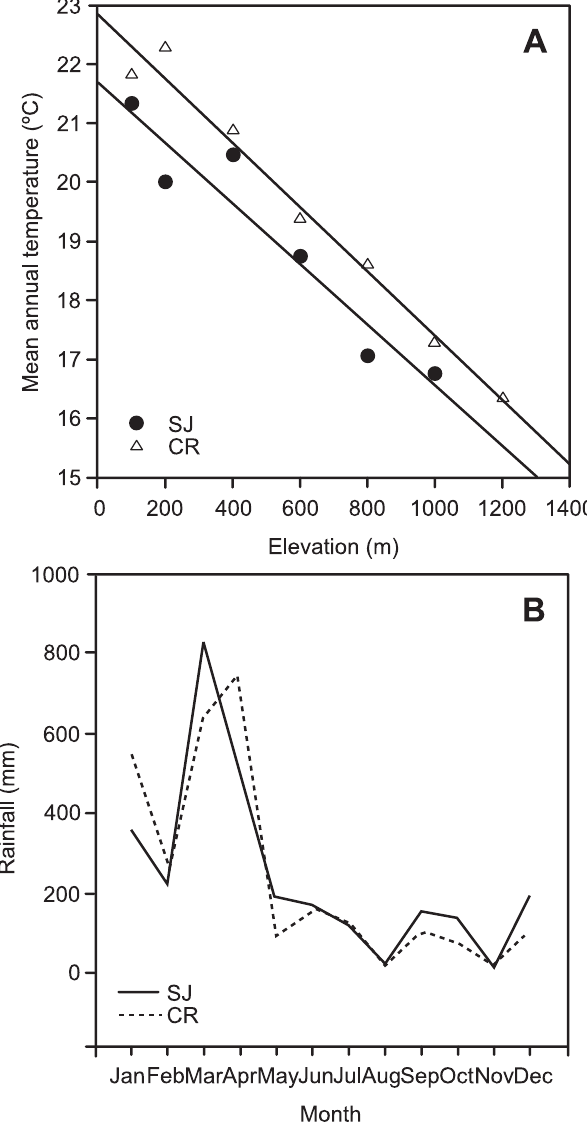
Figure 1. Variation of temperature and rainfall at the AWT. A) Predicted variation of Mean annual temperature as a function of elevation. Temperature decreased at an approximately rate of 1 u C per 200 m altitude and there was approximately 1 u C difference between the two localities sampled at the same elevation and B) Monthly variation of rainfall at the two localities within the region indicated that the dry season began on May and was extended and acute through November or December when the rainy season began. The highest values of rainfall were between February and May. Localities: South Johnston (SJ) and Carbine Range (CR).